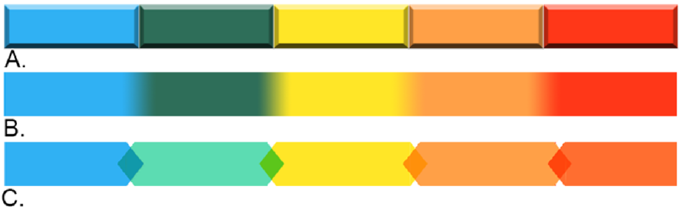
Figure 6. Visual representations of a dynamic overlapping process. ( A ) 3D form, ( B ) colour gradient, and ( C ) overlapping arrows.